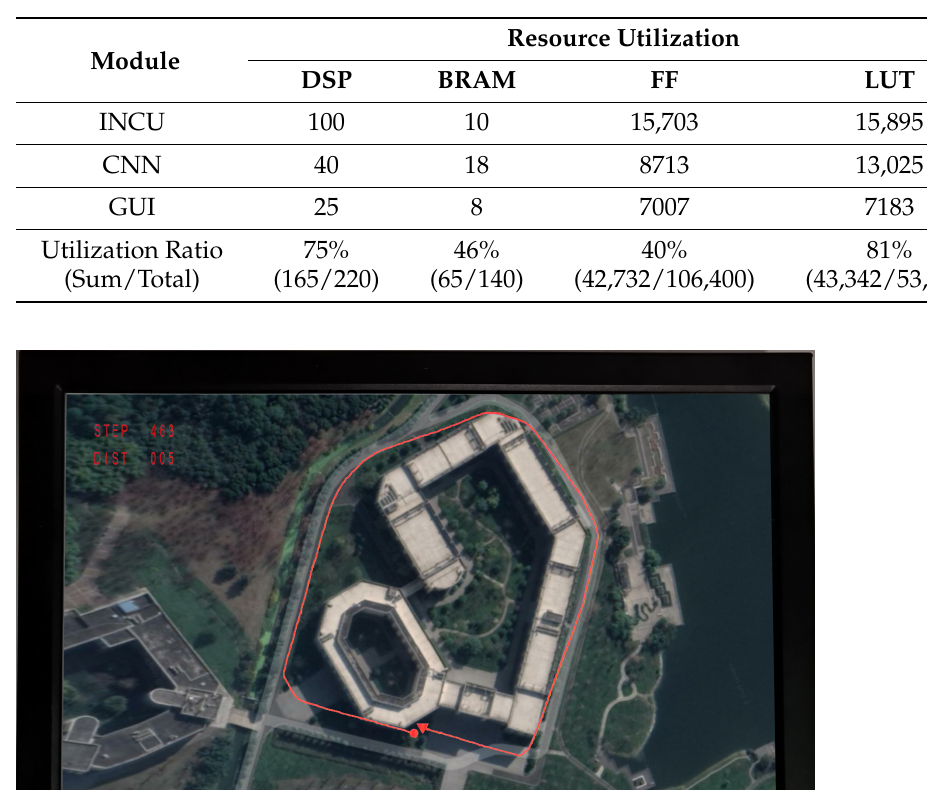
Table 3. Hardware module resource utilization.